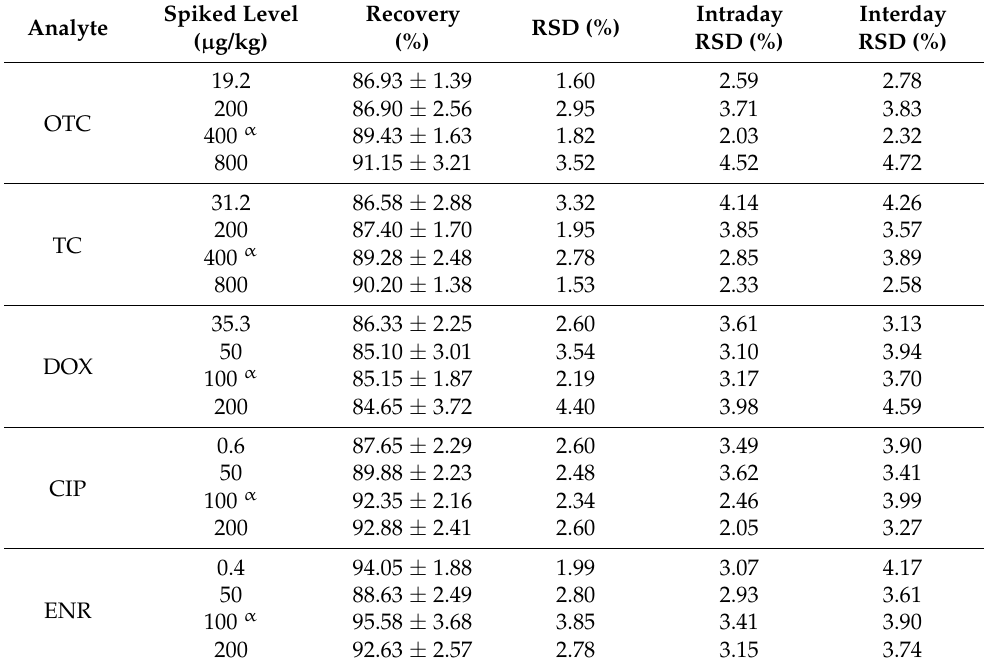
Table 2. Recovery and precision for analyses of blank blended whole chicken egg spiked with OTC, TC, DOX, CIP and ENR (n = 6).